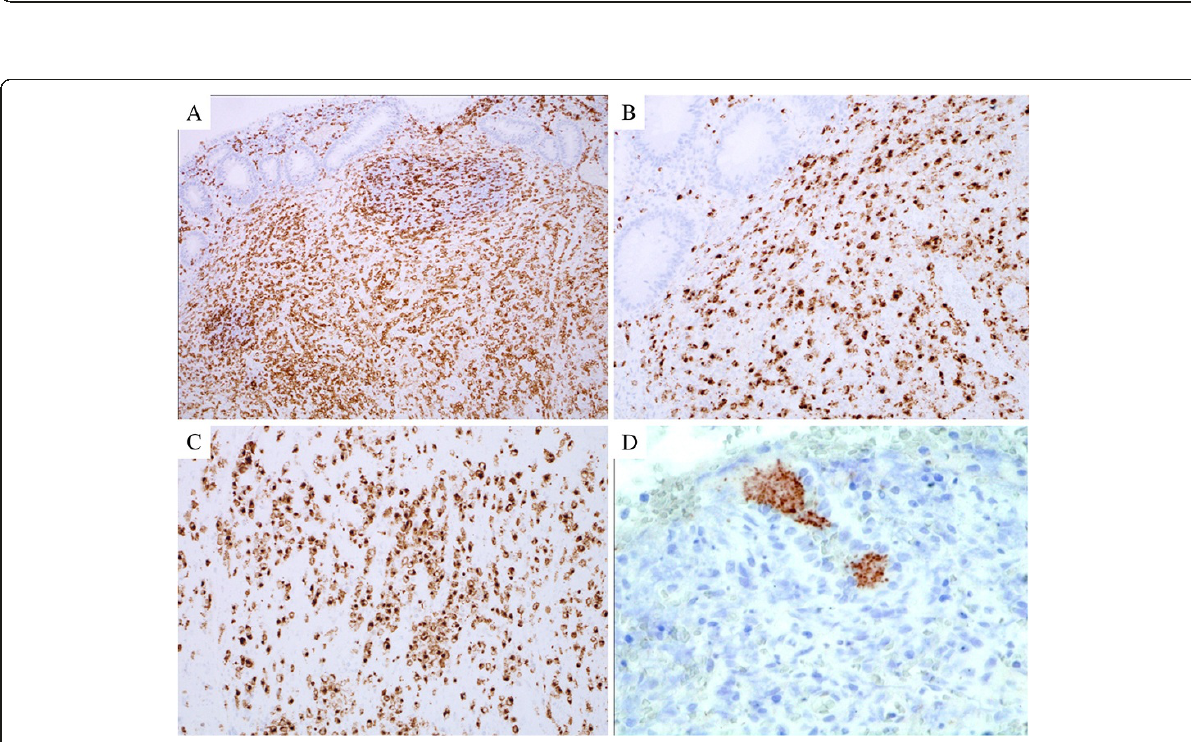
Figure 2 Immunohistological findings in the appendix. (A ) CD3-positive tumour cells distributed mainly in the submucosal and muscle layers (×100). Infiltrating atypical large lymphoid cells are positive for ( B ) CD4 and ( C ) TIA1 (×200). TIA1-positive lymphoma cells invade the muscle layer. ( D ) Rod-like substances in the foveolar pit are positive for anti-East Asian type H. pylori CagA antibody